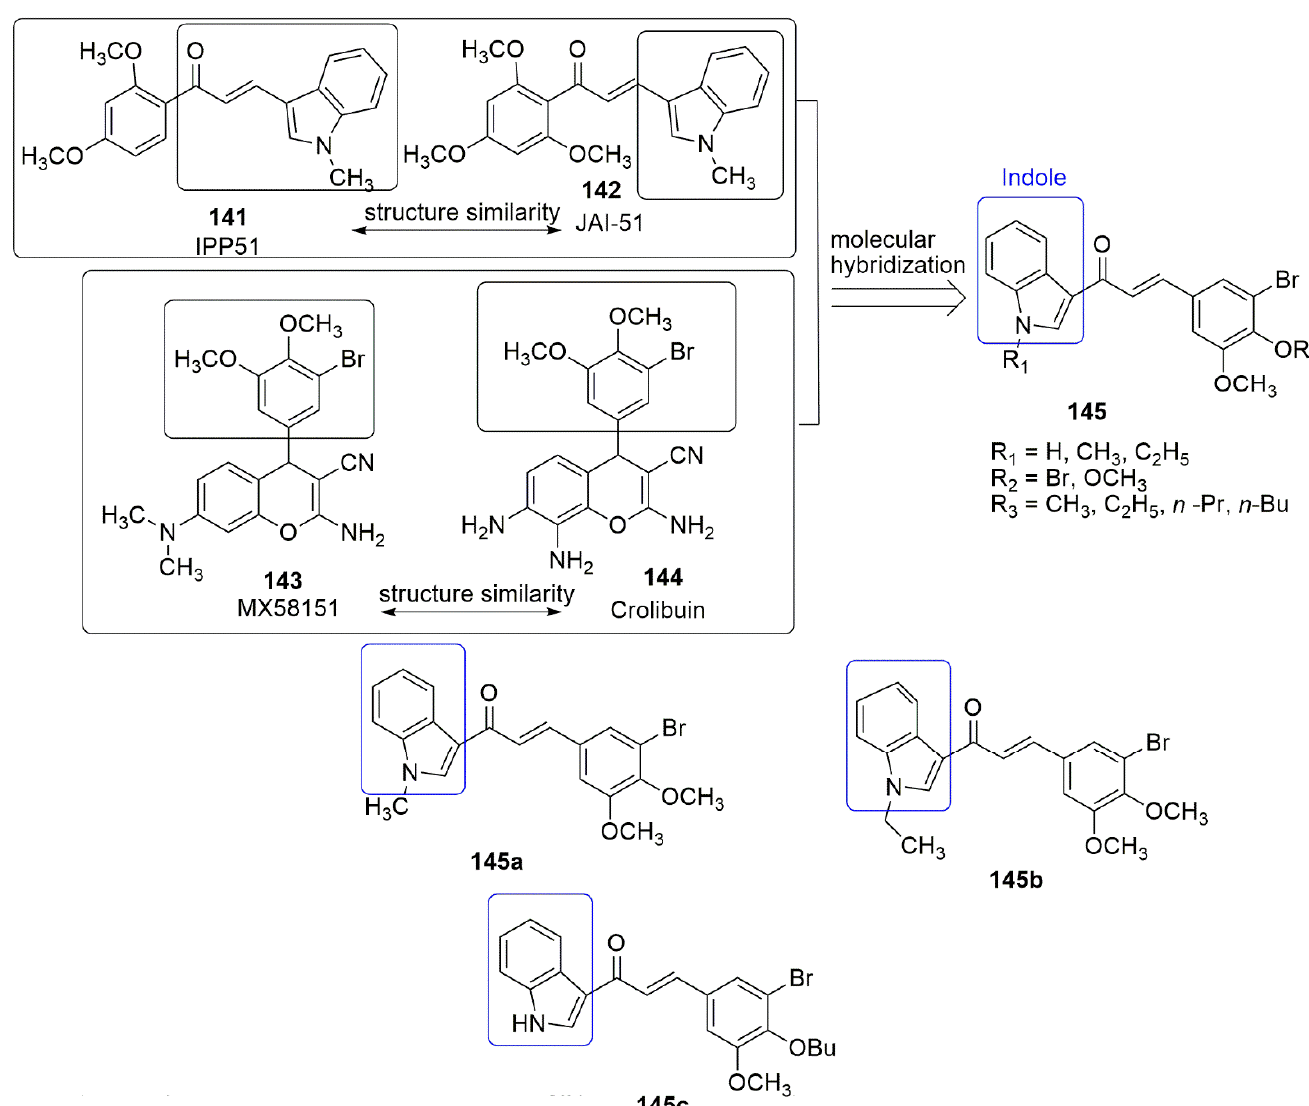
Figure 39. Amalgamation of indole–chalcone scaffolds as tubulin-targeting anti-cancer agent. Substituting the double bond in CA-4 ( 1 ) with the hybridized carbonyl group(sp2) provides molecules such as phenstatin 146 , which will maintain the cis orientation of the two rings, a feature of CA-4, liable for presenting better biological properties [129,130]. Many phenstatin-containing molecules have been reported without removing the 3,4,5-timethoxyphenyl ring but substituting the 3-hydroxy-4-methoxy phenyl ring with various heterocyclic rings, including the BPR0L075 ( 149 )-bearing carbonyl bridge and indolyl scaffold. BPR0L075 can effectively impede cancer cell growth and tubulin polymerization [131,132]. These observations prompted Kode and colleagues to report alterations and the biological effectiveness of phenstatin, indole, and chalcone scaffolds. Subsequently, a new phenstatin based indole-linked chalcone compounds ( 151 ) was designed, synthesized, and evaluated against several cancer cell lines [133]. Compound 151a (R 1 = CH 3 , R 2 = R 3 = OCH 3 , and R 4 = H) demonstrates highly significant inhibitory activity against SCC-29B oral cancer cells with GI 50 < 0.1 µ M. In contrast, high inhibitory activity against HEP-G2 cells was observed for compound 151b (GI 50 = 0.018 µ M), and compound 151c (GI 50 = < 0.1 µ M) showed significant inhibitory activity against HT-29 colon cancer cells. Compound 151a was further evaluated for its effect on tubulin polymerization. The results demonstrated that it causes destabilization of tubulin, leading to the disruption